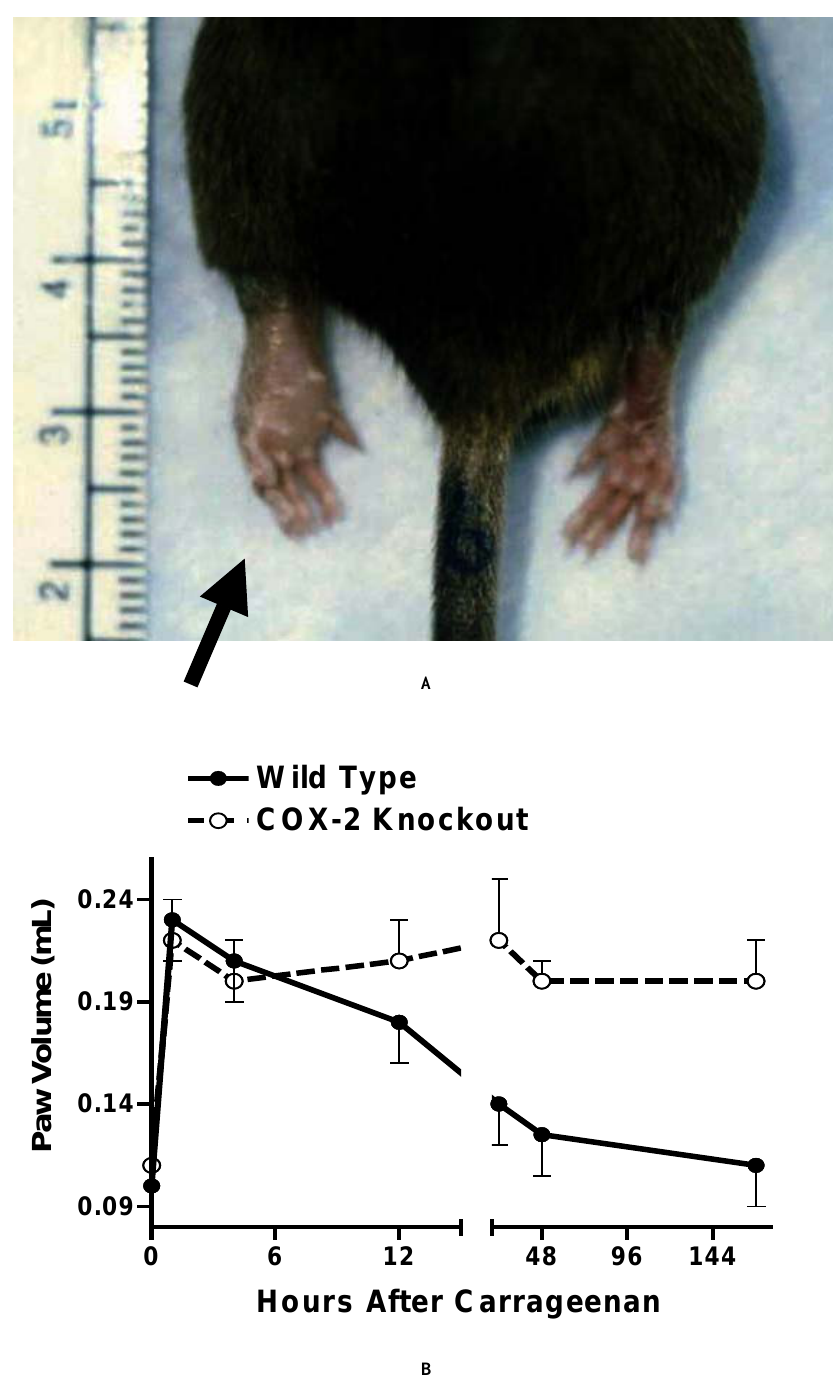
FIGURE 4. Carrageenan-induced inflammation of the paw in COX-2-deficient and wild type mice. Panel A shows the appearance of the paw of a mouse 1 week after subplantar injection of carrageenan (the paw on the left was injected). Note that the paw appears swollen compared to the noninjected paw. Panel B shows the change in paw volume in COX-2–deficient and wild type mice up to a week after carrageenan injection. While the edema resolves in the wild type mice, it is still apparent in the COX-2–deficient mice 1 week after the injection of carrageenan. Further details of these experiments can be found in Wallace et